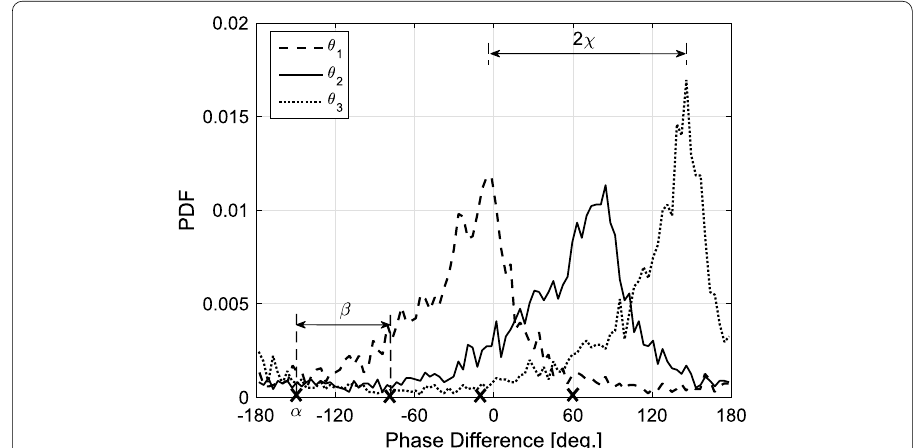
Fig. 7 Parametric codebook design for the UCA using the curvature parameter